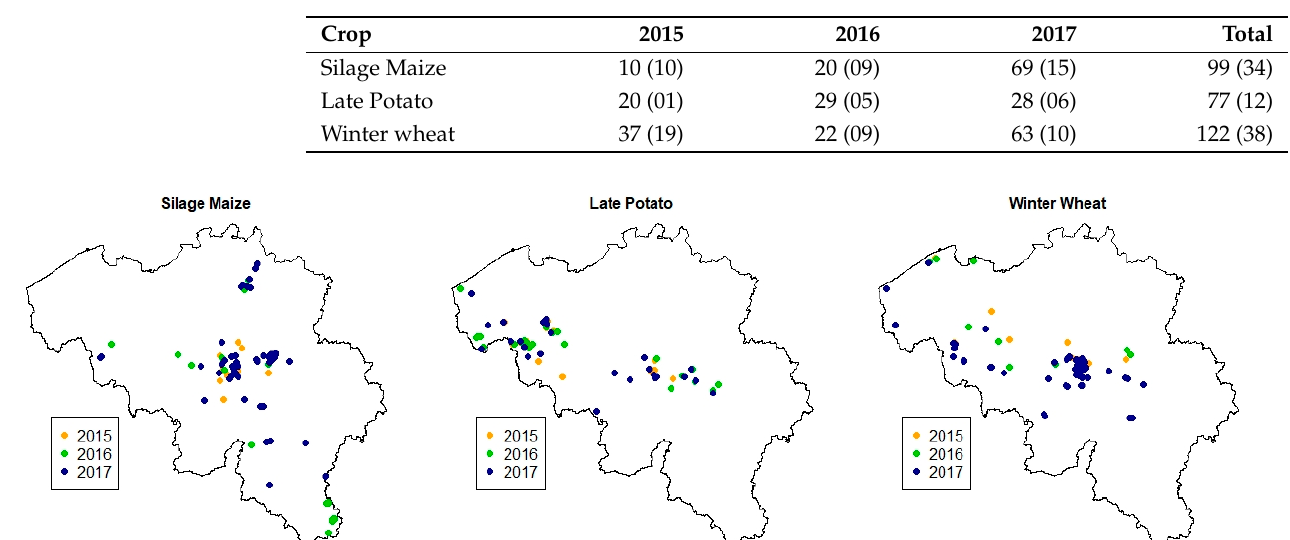
Figure 3. Location of arable fields in Belgium for 2015, 2016, and 2017 surveys of silage maize, late potato, and winter wheat.